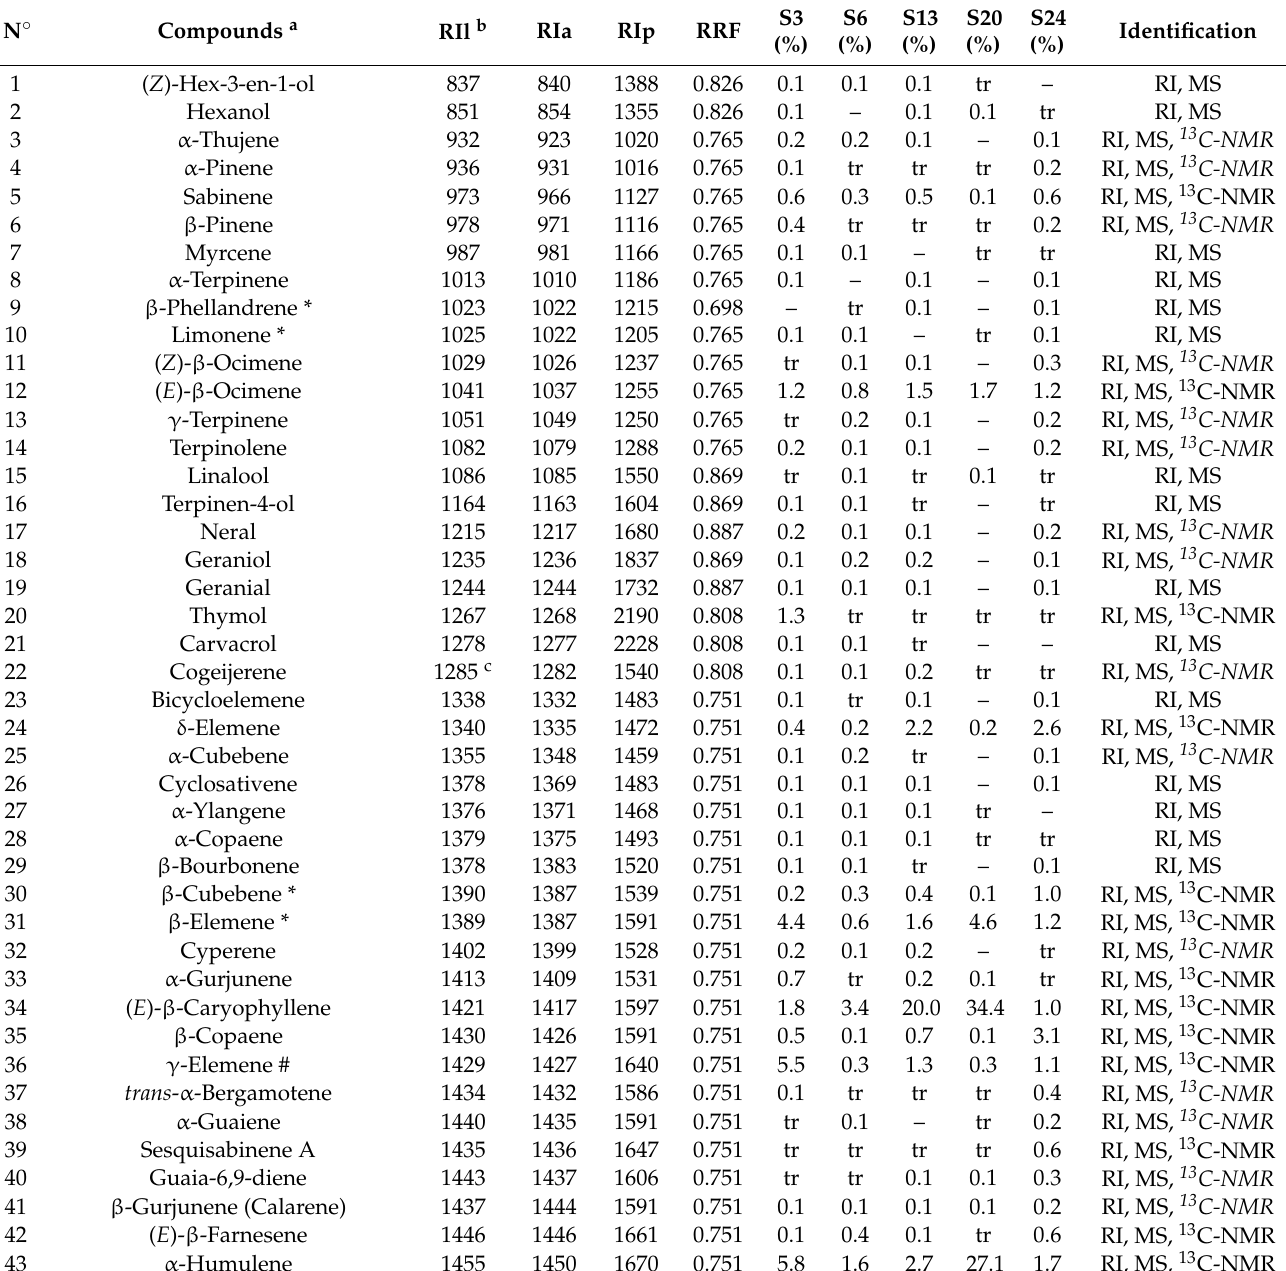
Table 3. Chemical composition of five leaf EO samples from N. acuminata